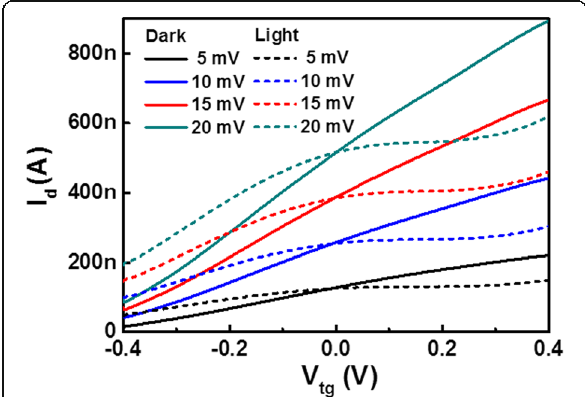
Fig. 4 I d -V tg characteristic of SnSe 2 FET under illumination and in the dark